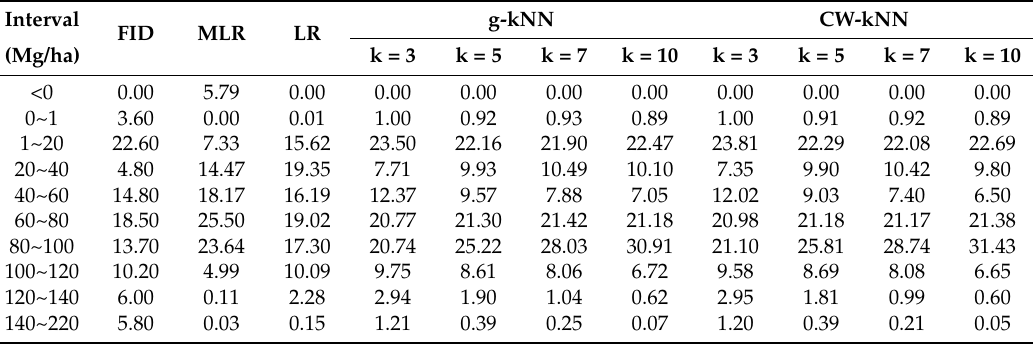
Table 2. Statistical percentages of forest aboveground biomass density (AGB) estimates falling in the biomass intervals for forest ecosystem AGB maps using MLR, LR, g-kNN, and CW-kNN modeling. The reference AGB was obtained from a forest inventory dataset (FID column).